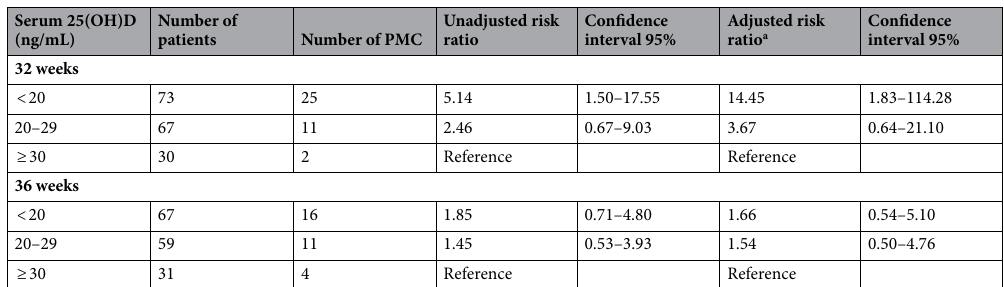
Table 2. Maternal vitamin D status at 32–36 weeks’ gestation and risk of placenta-mediated complications in women at high risk. PMC placenta-mediated complication. a Multivariate analysis adjusted for lupus, diabetes and personal history of PMC, at each concentration of serum